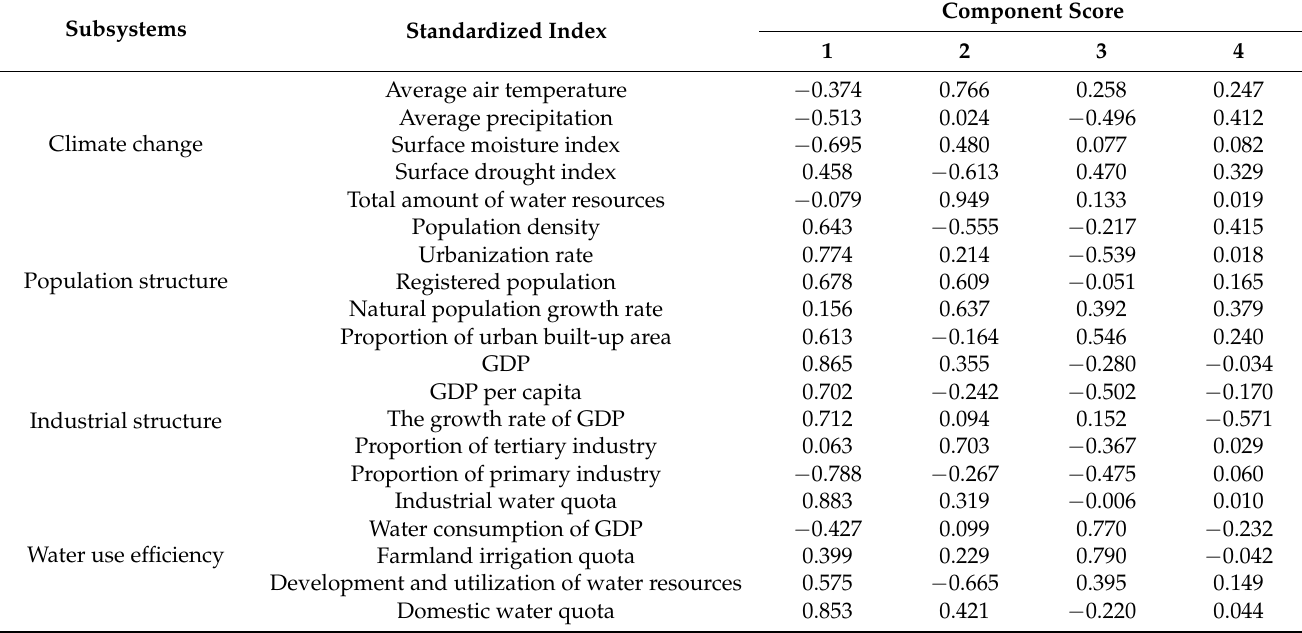
Table A5. Component score coefficient